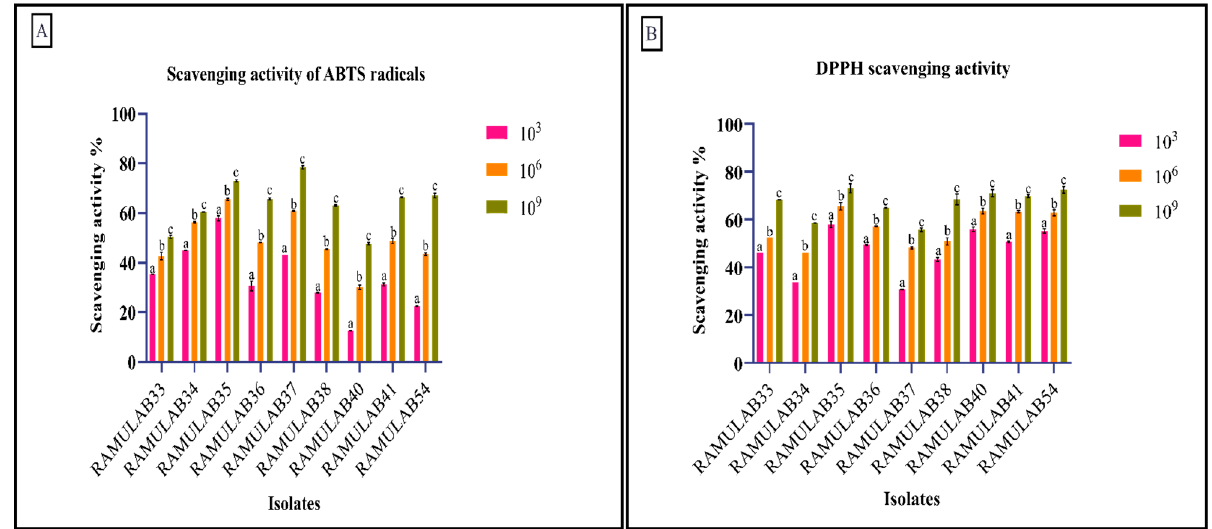
Figure 6. Shows of the isolates’ ( A ) capacity for scavenging ABTS radicals and ( B ) capacity for scavenging DPPH free radicals. The mean and SD are used to express data. According to the Duncan multiple range test, the means of the scavenging activity of various CFU/mL with distinct superscripts (a–c) are significantly different ( p ≤